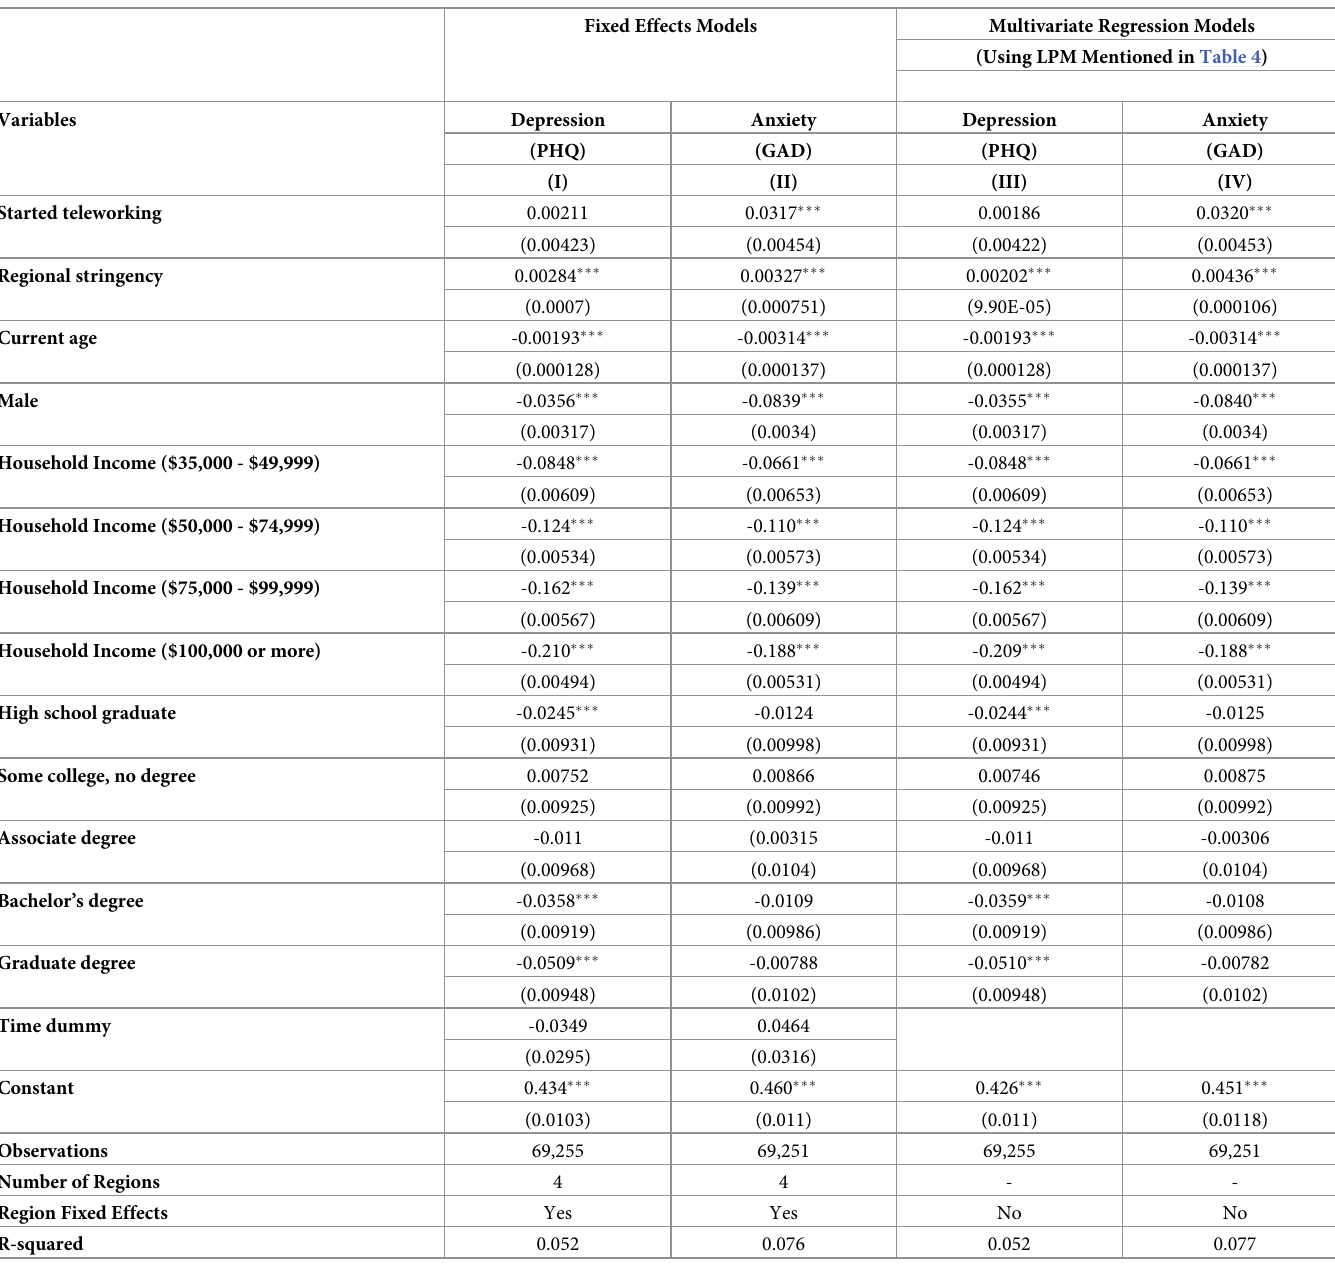
Table 5. Fixed effect and multivariate OLS model